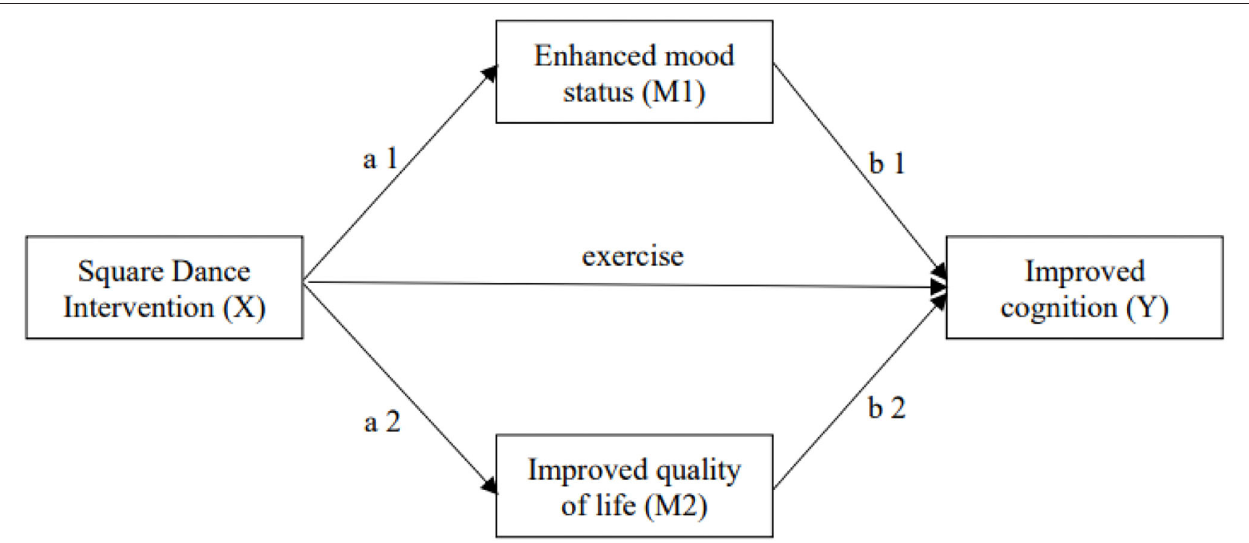
FIGURE 1 | The hypothesis-mediating